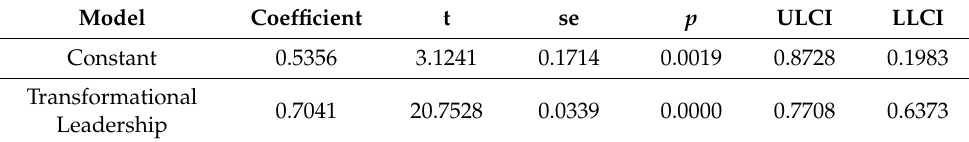
Table 7. Model Summary (path-b and ć ).